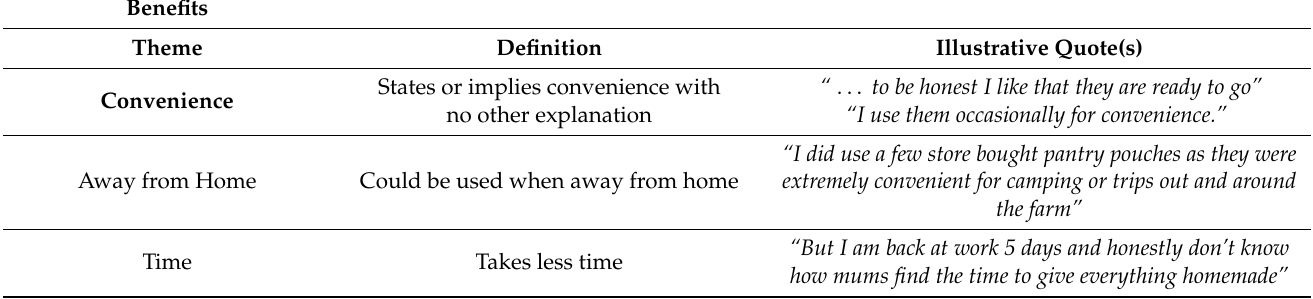
Table 2. Categories, themes, and illustrative quotes related to parental perceptions of the use of squeezable baby food pouches via parenting discussion threads as identified by netnographic analysis 1